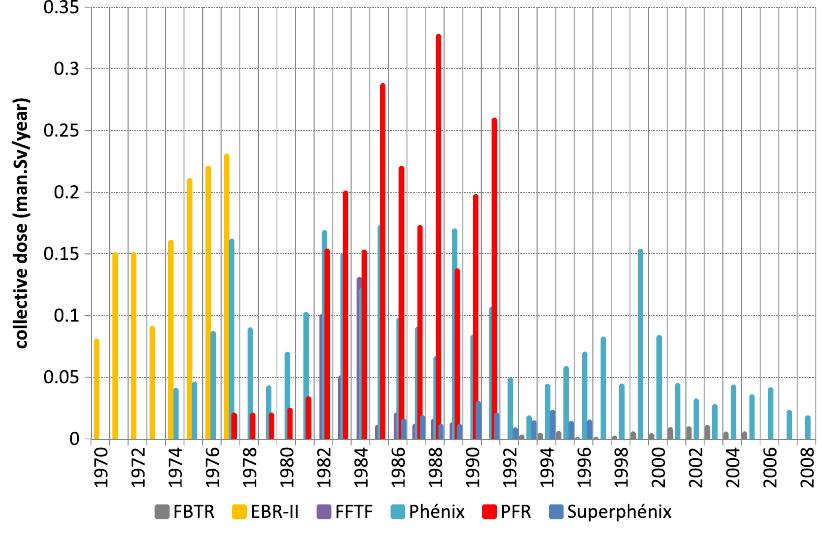
Fig. 8. Collective dose for different